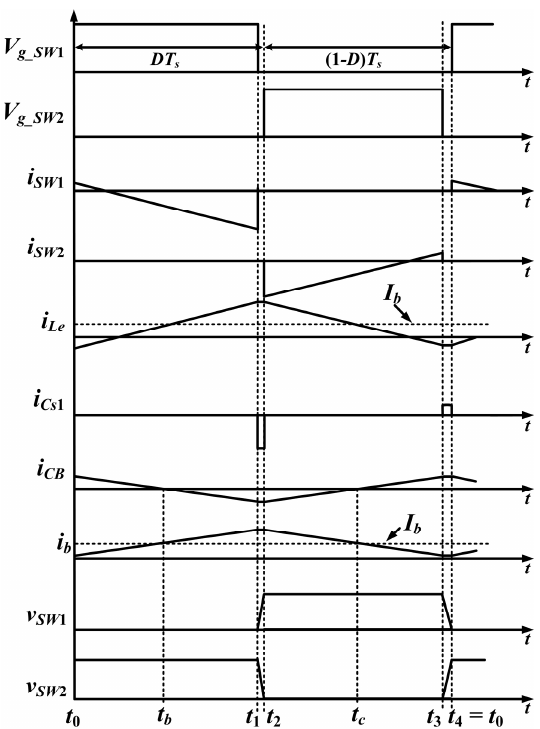
Figure 8. Voltage and current waveforms of the proposed converter for buck forward-conversion.